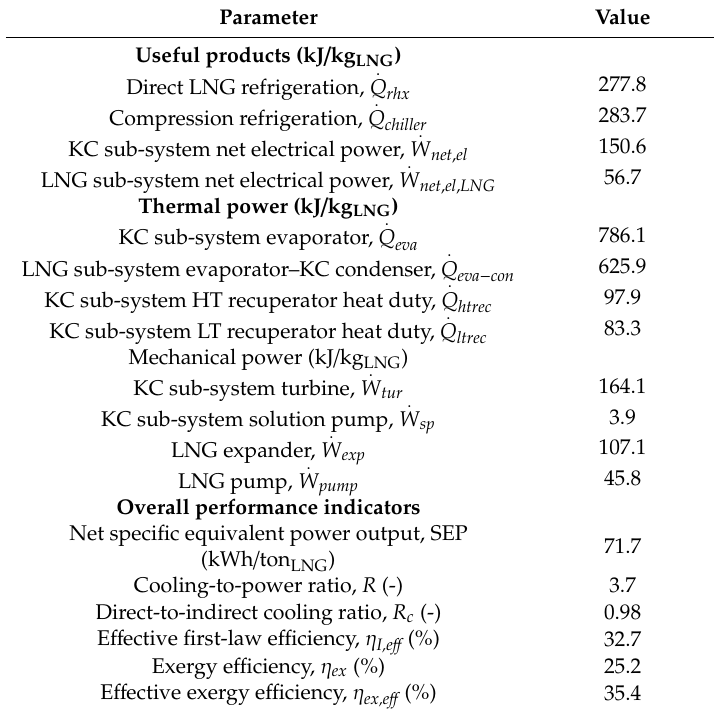
Table 3. LNG-assisted KC-based poly-generation system overall energy- and exergy-based performance characteristics at nominal conditions listed in Table 1.